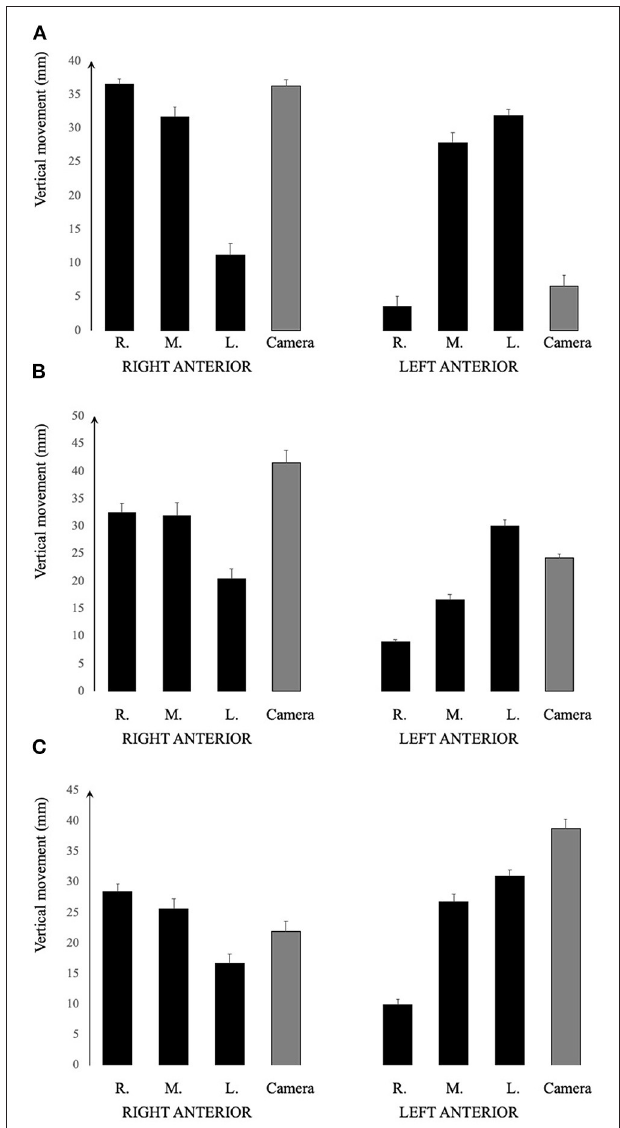
FIGURE 5 | Graphical illustration of the vertical movement of the different positions of the goggles. (A) Otometrics. (B) Interacoustics recording device over the right eye. (C) Interacoustics recording device over the left eye. It would seem that the middle portion of the goggles moved more consistently far vertically, regardless of which canal plane tested. However, the sides of the goggles including the position of the recording device varied depending on the canal plane as well as on the position of the recording